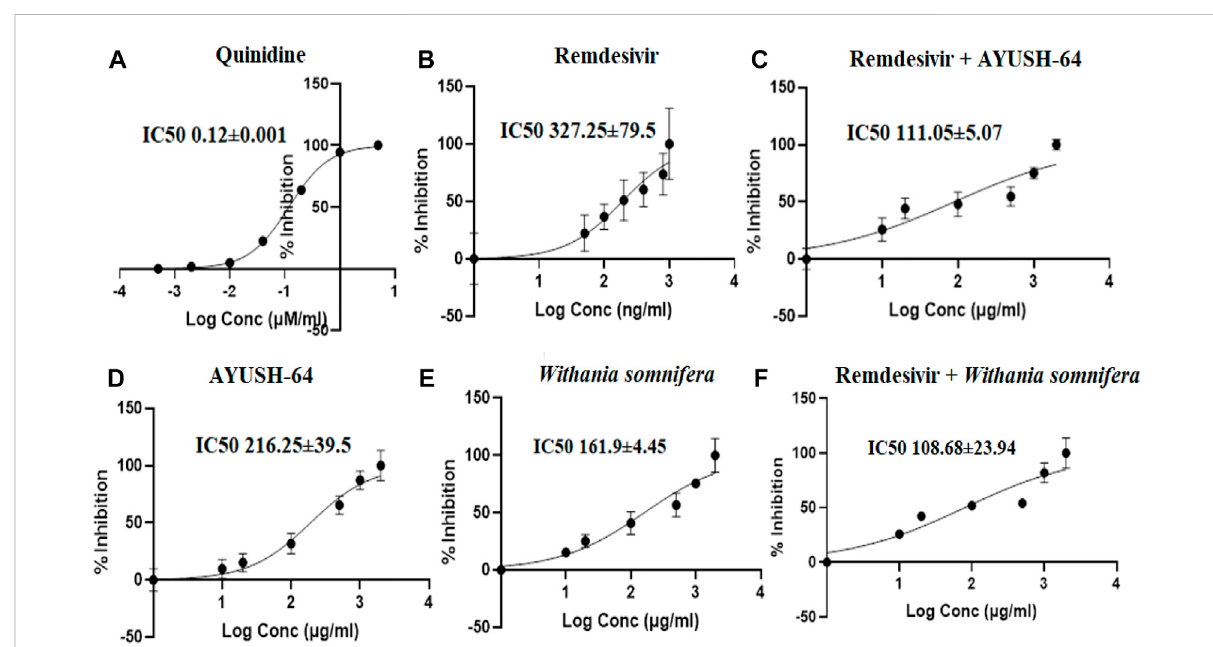
FIGURE 7 Effect of (A) quinidine (100 – 0.01 μ M/ml), (B) remdesivir (1,000 – 1 ng/ml), (C) remdesivir + AYUSH-64 (2001 – 1.001 μ g/ml), (D) AYUSH-64 (2000 – 1 μ g/ml), (E) Withania somnifera (2000 – 1 μ g/ml), and (F) remdesivir + Withania somnifera (2001 – 1.001 μ g/ml) on CYP2D6-mediated hydroxylation of dextromethorphan. The graphs have been plotted for log conc. vs. percentage of